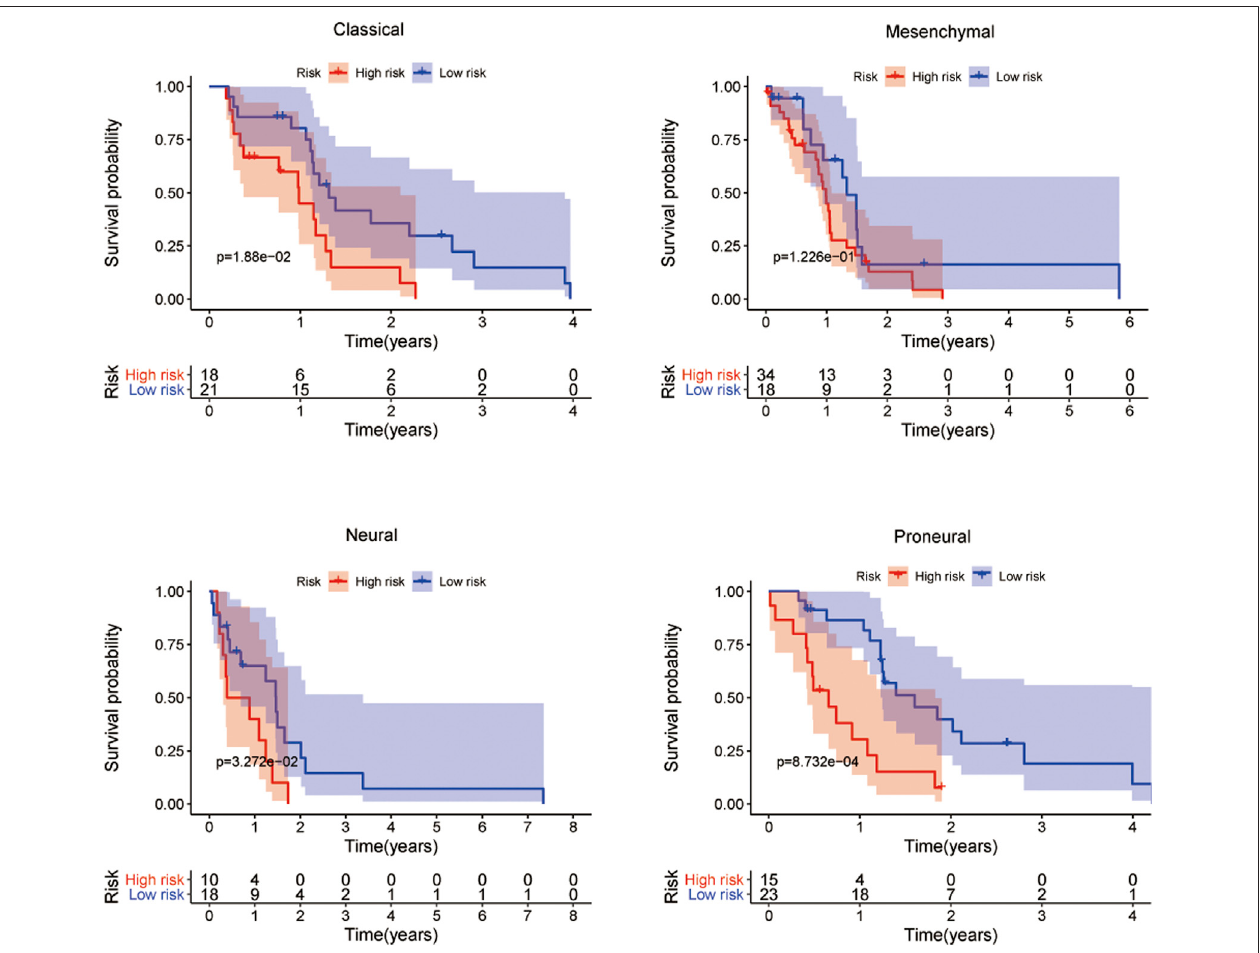
FIGURE10| Theprognosticvalueofthe fi ve-mRNAsignatureinthesubtypesofGBM.Kaplan – MeiersurvivalcurveanalysisofOSinthehigh-andlow-riskgroups for patients with the four subtypes. Kruskal – Wallis test was used to compare the expression levels of each mRNA in the four subtypes of GBM.